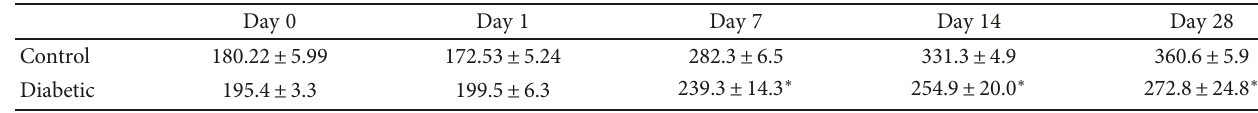
Table 2: Body weight (g) of diabetic and control rats.